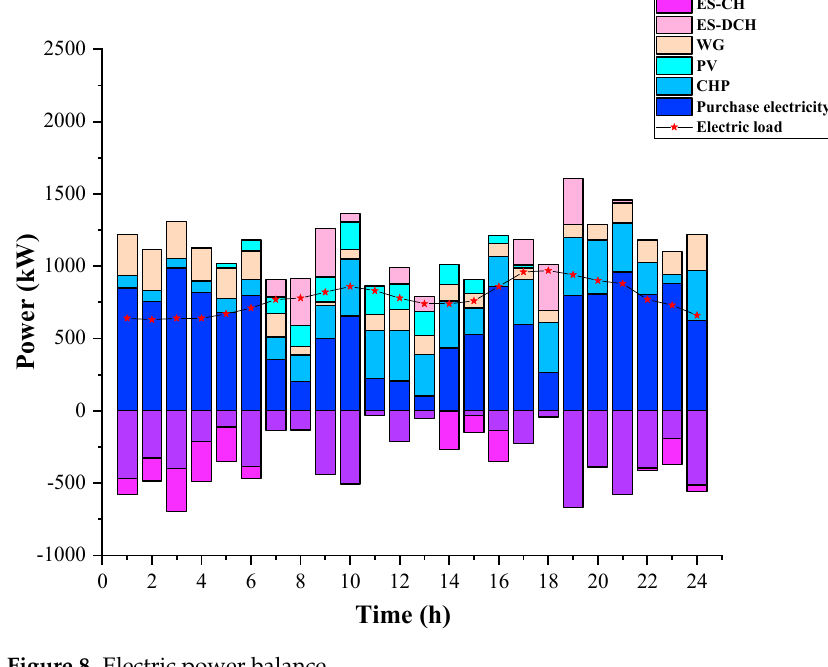
Figure 8. Electric power balance.